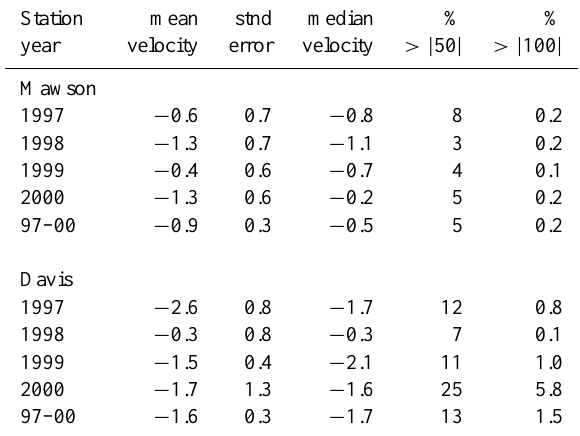
Table 2. Mean, standard error, and median vertical velocities for in- dividual years and the combined data sets from Mawson and Davis. Percentage of measurements > | 50 | ms − 1 and > | 100 | ms − 1 are given. The number of profiles can be obtained from Table